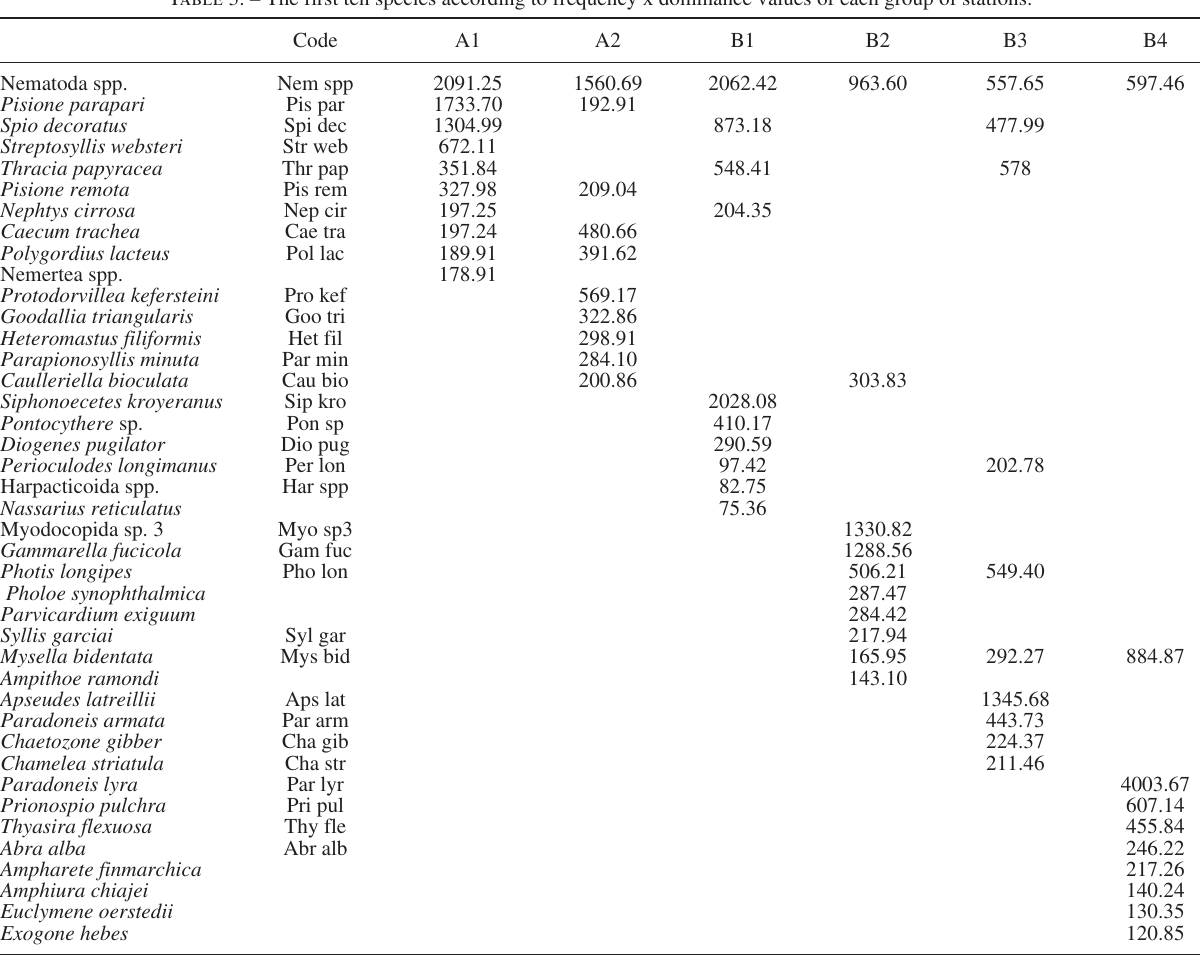
Table 3. – The first ten species according to frequency x dominance values of each group of